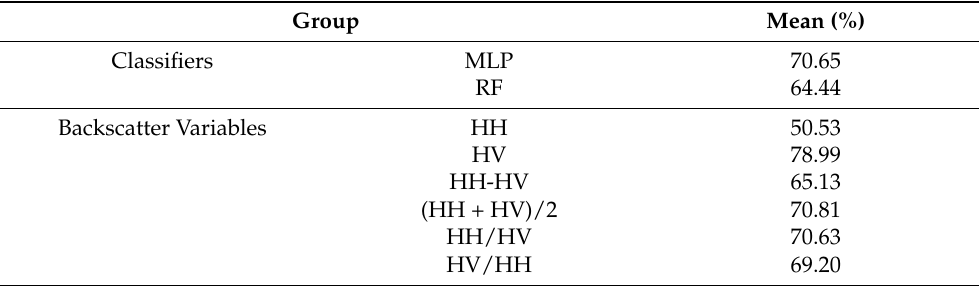
Table 8. Mean comparison of BCR (%) obtained from Tukey’s HSD test according to classifiers and backscatter